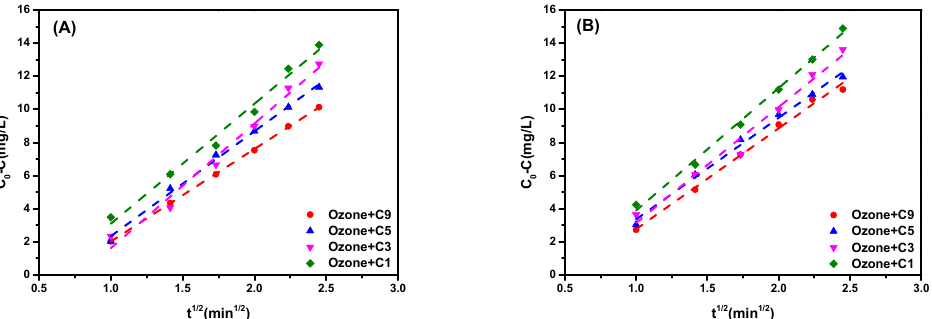
Figure 9. Plots of intraparticle diffusion model for COD removal of sample A ( A ) and sample B ( B ) by catalytic ozonation.